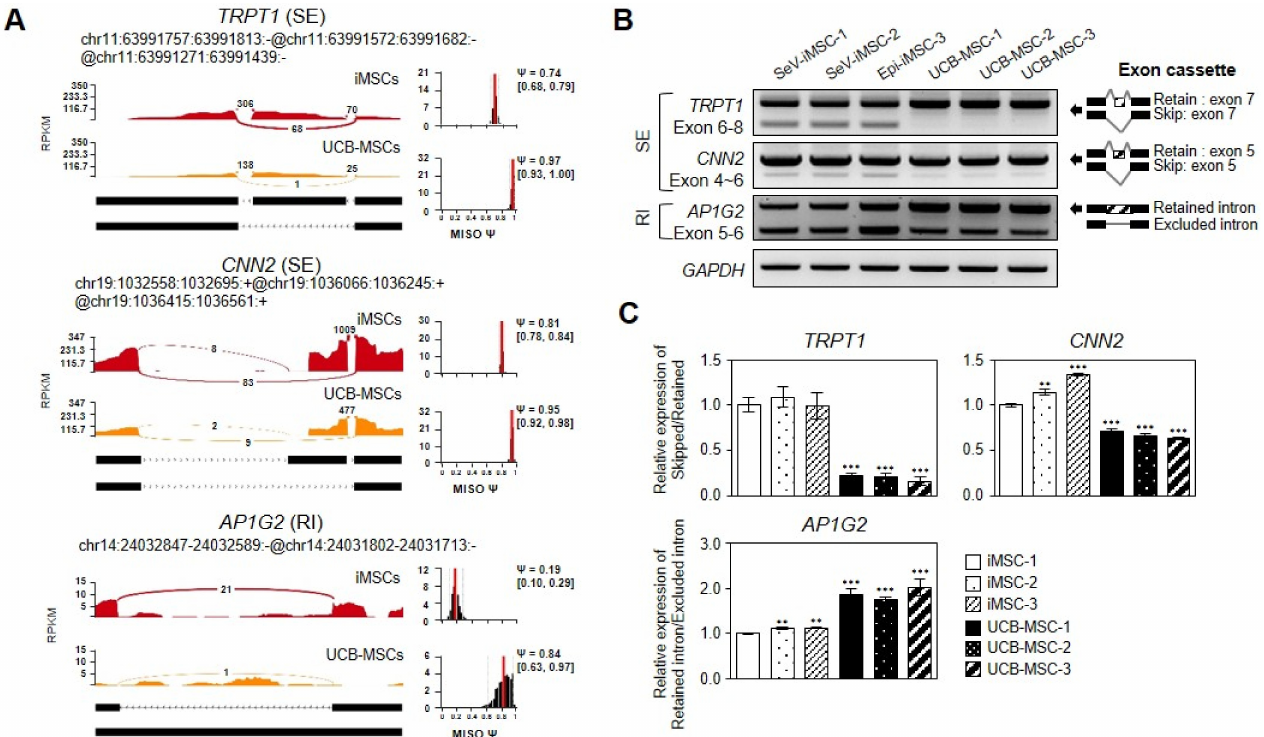
Figure 5. Sashimi plots and RT-PCR showing SE events in selected DSGs. ( A ) The sashimi plots of SE events in TRPT1 and CNN2, and RI events in AP1G2 were constructed with the MISO package. The vertical axis on the left side of the main panel shows the counts of RNA-Seq reads spanning the junctions in each region. The genomic coordinates for individual splice sites are shown at the top, and the schematic of each splicing event is shown at the bottom. Red indicates the iMSCs (C_MSC-1), and orange indicates the UCB-MSCs (C_MSC-3). The data are represented as reads per kilobase per million (RPKM). The estimated Ψ (red line) MISO values are shown in the right panels. ( B ) Representative AS events validated by RT-PCR analysis. RT-PCR was performed with primers in constitutive exons (dark gray in the scheme) of the three selected genes with SEs (TRPT1 and CNN2) and RIs (AP1G2). RT-PCR was performed with the same samples used in RNA-Seq. GAPDH was used as an internal control. ( C ) Quantitative analysis of the PCR results in B. The graphs show the ratio between isoforms with retained and skipped (or intron retention) exons. The data are relative to iMSC-1 and are shown as means ± SDs of three independent experiments. ** p < 0.01 and *** p <